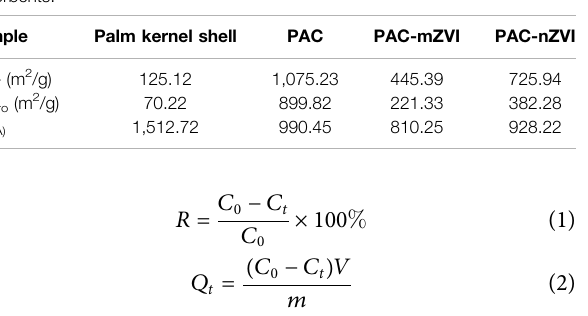
TABLE 1 | Textural features of palm kernel shell, PAC, PAC-mZVI, and PAC-nZVI